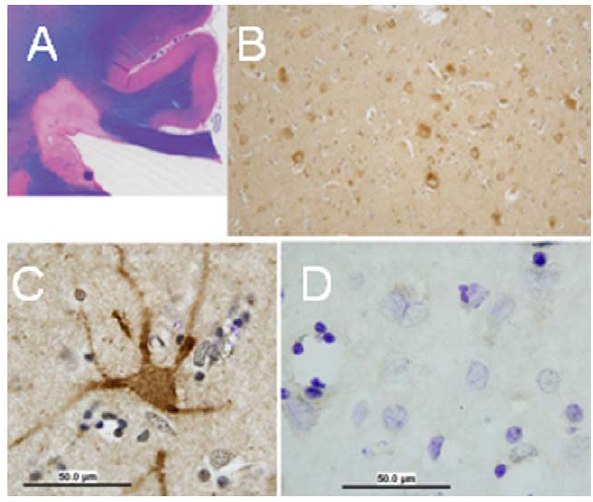
Figure 8. Immunostaining for Kv1.3 in autopsy brain tissue in patients with multiple sclerosis. (A) Section presents an area in the cortex showing a demyelinating lesion using hematoxylin and eosin staining. (B) Several neurons are seen within this lesion immunostaining for Kv1.3. (C) At higher magnification, cell body and neurites are immunostained for Kv1.3. (D) Staining with primary antibody only shows absence of immunostaining.